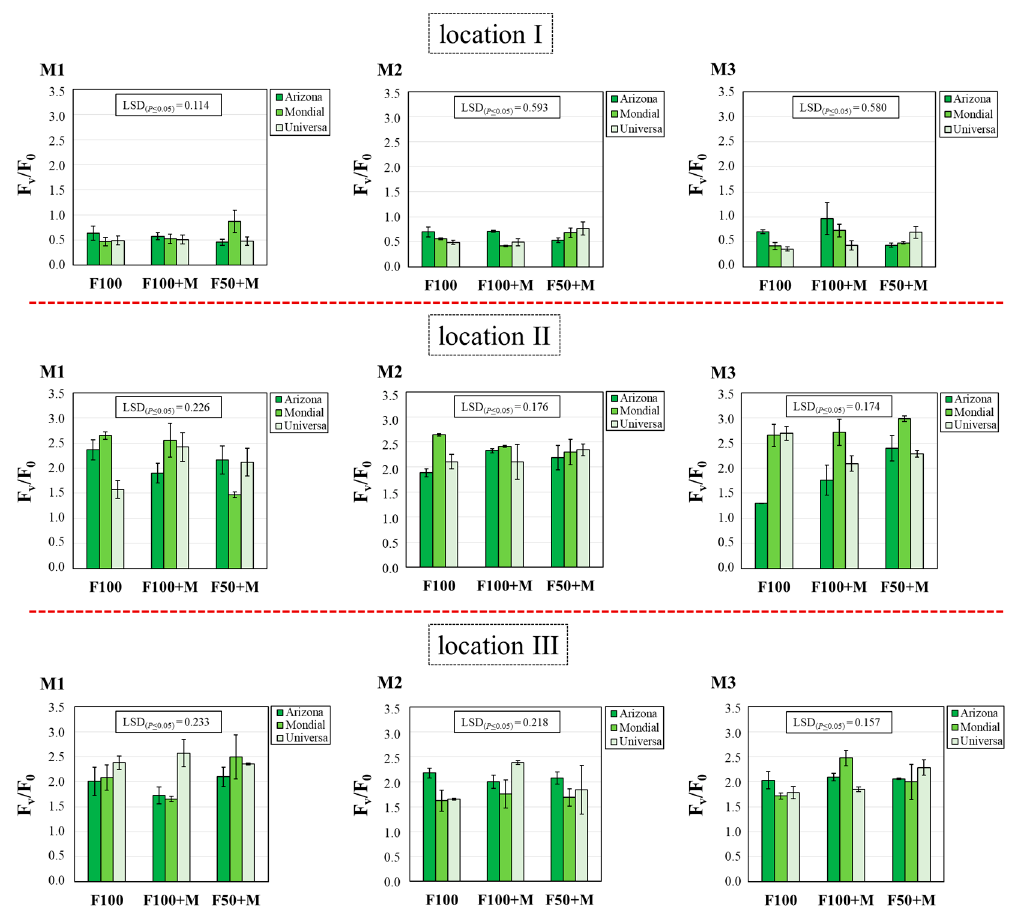
Figure 6. F v /F m ratio of leaves of early crop potato organically grown in highly calcareous soils as affected by fertilization management, soil type and potato cultivar. The Least Significant Difference (LSD) interaction was calculated with the Fisher’s protected LSD test at α = 0.05. Each bar indicates means ± standard deviation ( n = 5). F100: optimal fertilization without mycorrhizal inoculation (control); F100+M: optimal fertilization with mycorrhizal inoculation; F50+M: sub-optimal fertilization with mycorrhizal inoculation; ‘Arizona’, ‘Mondial’ and ‘Universa’: potato cultivars. M1, M2 and M3: first, second and third measurement date.